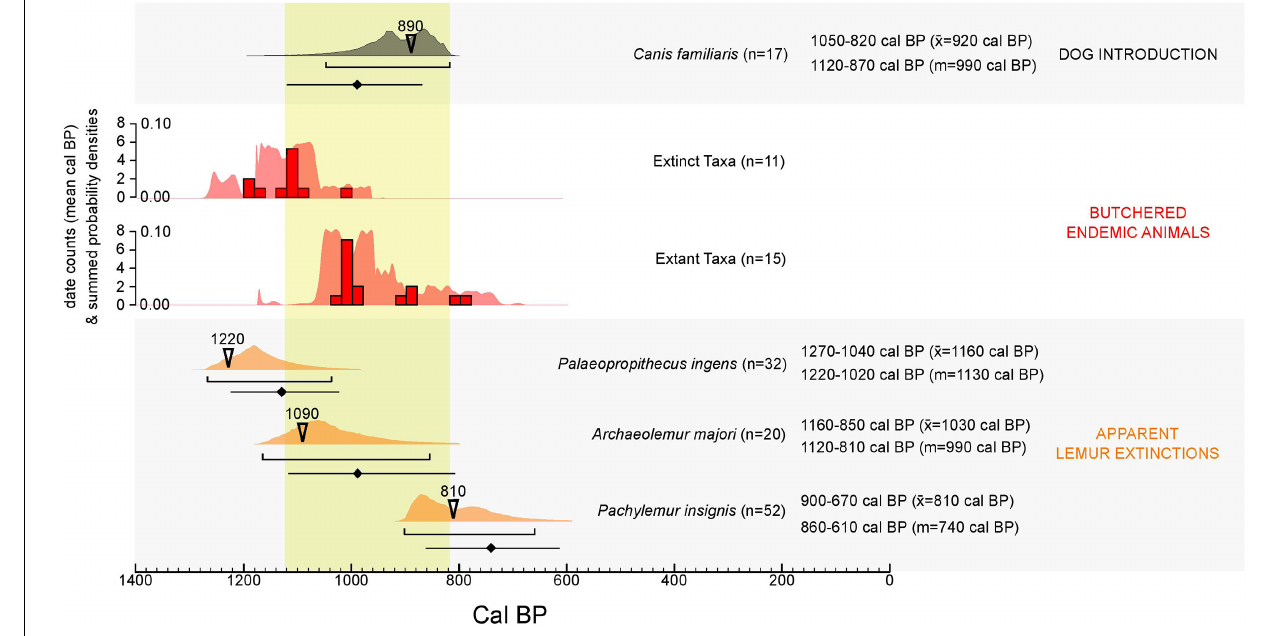
FIGURE 5 | Dog introduction event estimate compared to dates from butchered endemic animal bone and giant lemur extinction event estimation. Numbered arrowheads mark the mean calibrated date from the oldest recognized dog and youngest recognized giant lemur belonging to each taxon. See Figure 4 for explanation of confidence intervals for event estimation. Note that extinction confidence intervals consider only data from purified collagen. Dates from butchered animal bone are binned in 20-year intervals (saturated color) and are also displayed through summed probability distribution overlays (unsaturated color). Butchered extinct taxa represented in the histogram include Pachylemur insignis , Archaeolemur majori , Hippopotamus sp., Aepyornis maximus , and Mullerornis modestus . All of these taxa disappear from the subfossil record by ∼ 800 cal BP (Crowley, 2010). Butchered extant taxa in the histogram include only P. verreauxi .